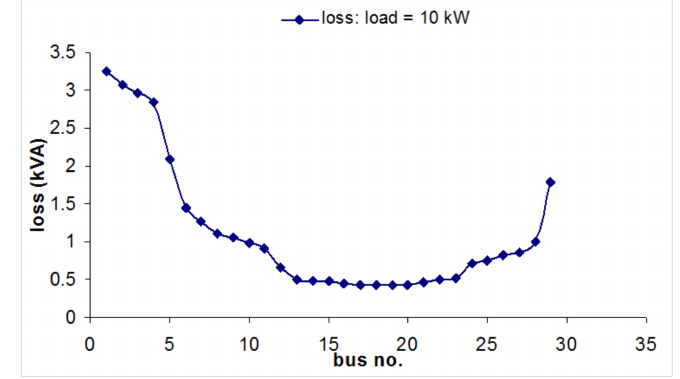
Figure 14. Variation of losses with location of PV system for a load of 10 kW.